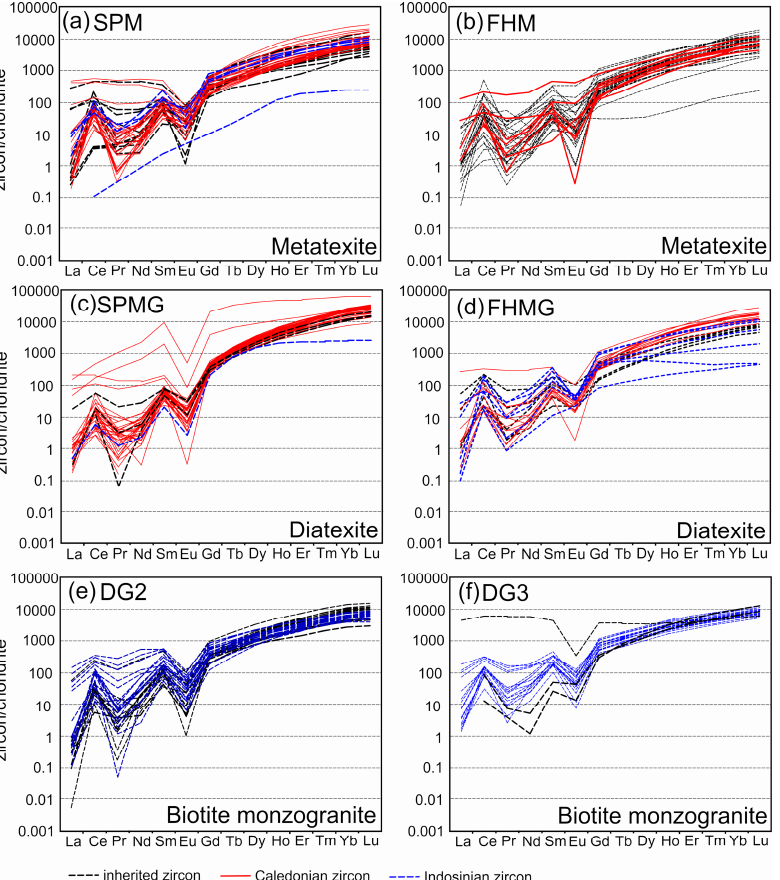
Figure 8. Chondrite-normalized REE patterns of zircons from samples of Fuhuling. ( a ) metatexite sample (SPM). ( b ) metatexite sample (FHM). ( c ) diatexite sample (SPMG). ( d ) diatexite sample (FHMG). ( e ) biotite monzogranite sample (DG2). ( f ) biotite monzogranite sample (DG3). The black dotted line represents the inherited zircon cores, the red line represents the early Paleozoic zircon and the blue dotted line represents the Indosinianzircon. Chondrite values are from [58]. For sample DG3, three analyses of inherited cores had high concentrations of Th (664, 165, and 1027 ppm) and U (1087, 531, and 1209 ppm) with high Th/U ratios (0.61, 0.31 and 0.85). The REE patterns of inherited cores showed significantly negative Eu anomalies (Eu/Eu* = 0.32, 0.15 and